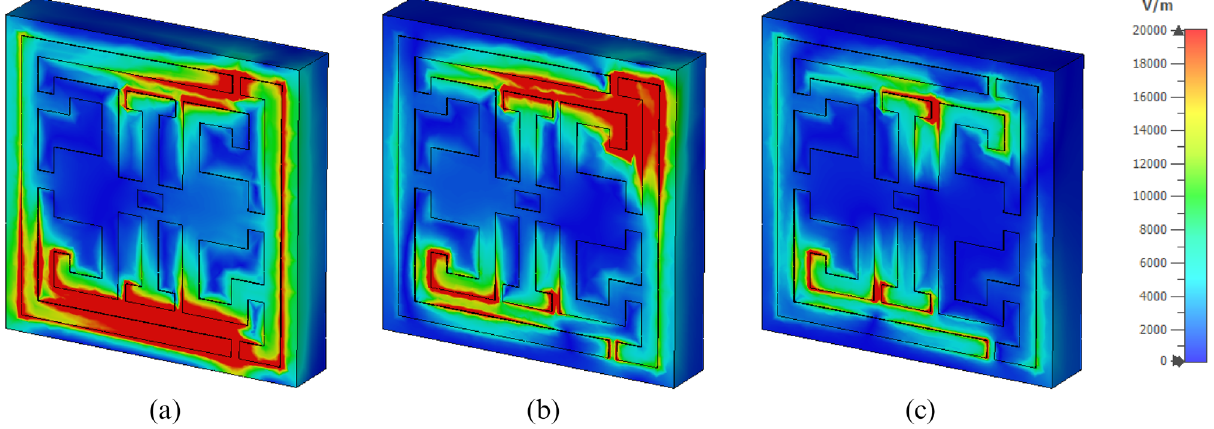
Figure 5. Electric field ( a ) 3.94 GHz, ( b ) 8.08 GHz, ( c ) 11.175 GHz (CST STUDIO SUITE 2019, https:// www. 3ds. com/ produ cts- servi ces/ simul ia/ produ cts/ cst- studio- suite) 30